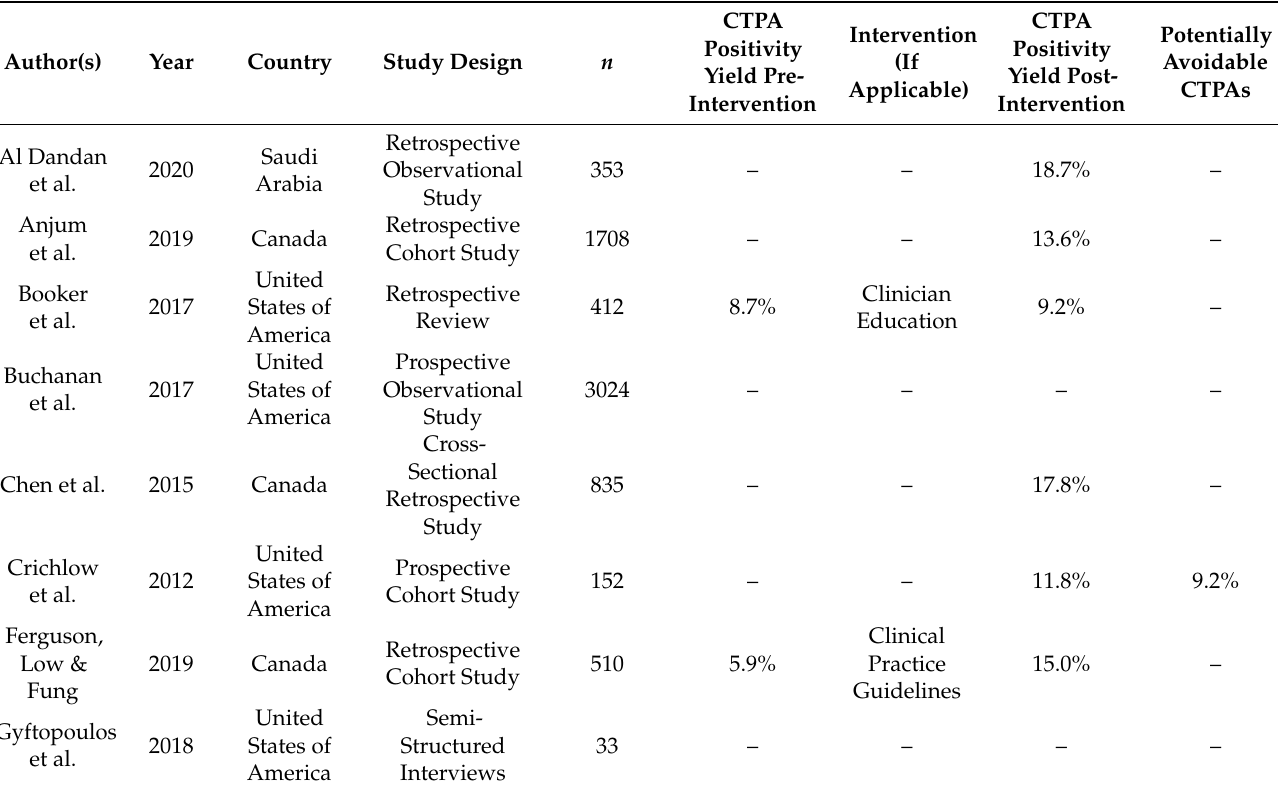
Table A1. Characteristics of Studies Included in Literature